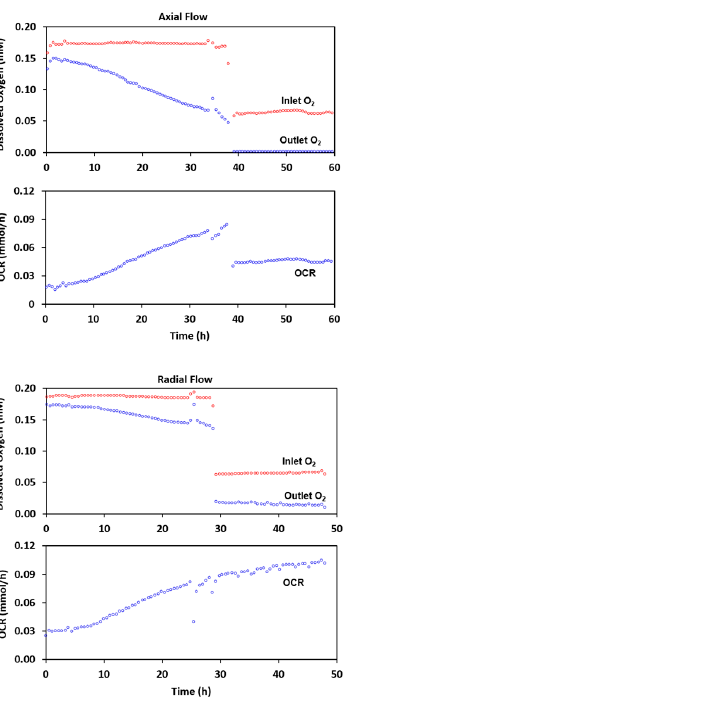
Figure 6. Comparison of axial and radial flow before and after oxygen limitation. Cultures perfused with medium near air saturation were grown to approximately identical levels of oxygen consumption. The difference between the inlet and outlet oxygen levels with axial flow was far greater than for radial flow (top and third graphs); the oxygen consumption rate profiles were similar (second and fourth graphs). When the inlet concentration was reduced to 0.06 mM, the outlet oxygen level with axial flow was below the detectable limit. However, it remained well above that value with radial flow.